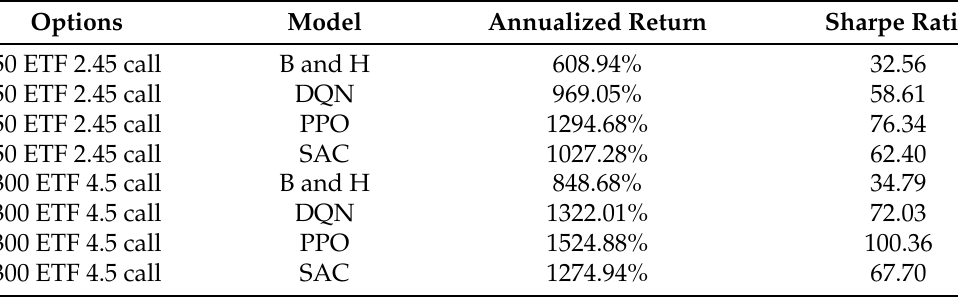
Figure 10. Trading performance on options. Table 5. Trading performance on different